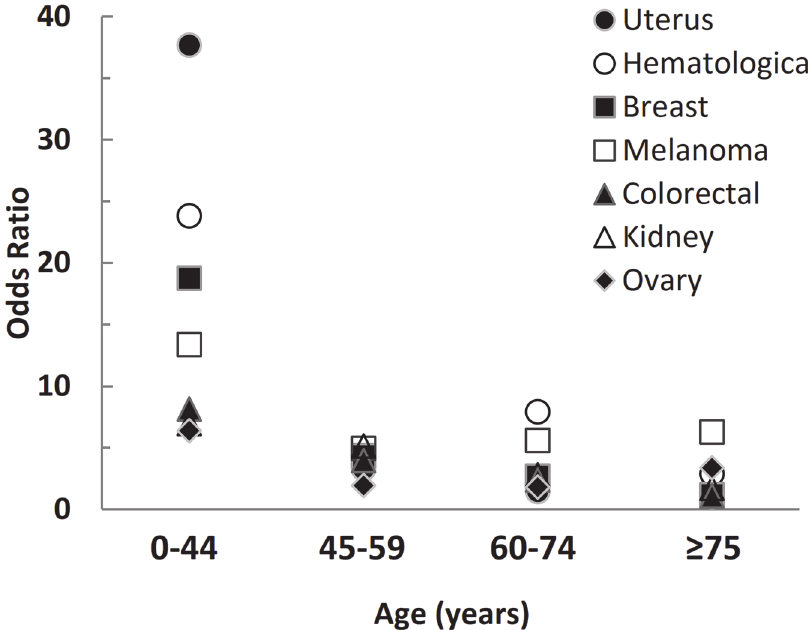
Fig 1. Odd ratio of various primary extra-thyroidal malignancies at different ages in 6,389 female patients affected by benign or malignant thyroid diseases.